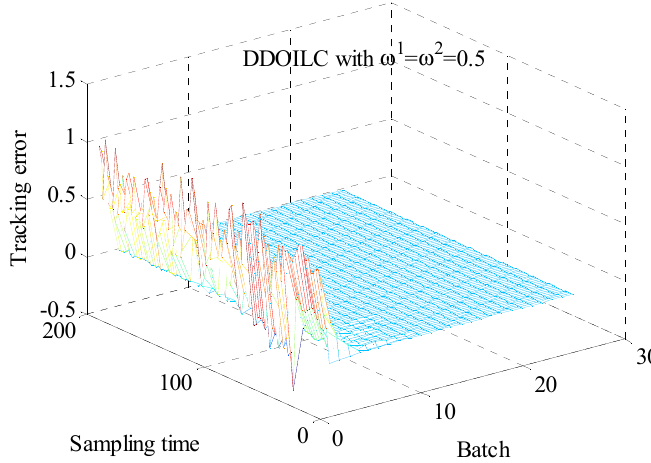
Figure 4. Tracking error mesh of the DDOILC.